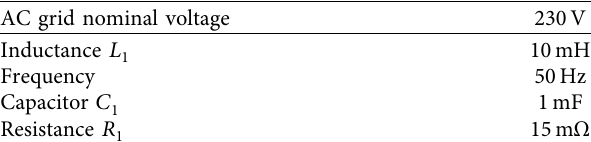
Table 4: Parameters of smart charging source.